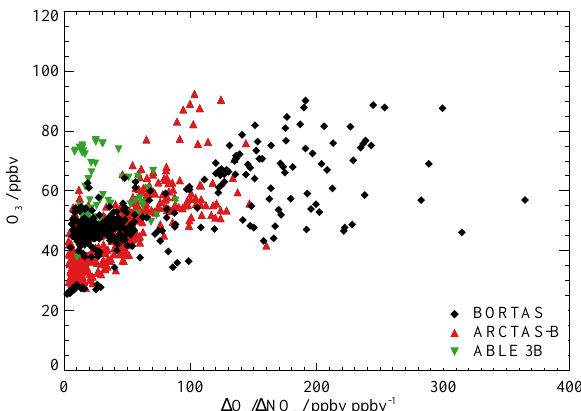
Fig. 14. Relationship between O 3 mixing ratio and OPE in boreal biomass burning plumes calculated from aircraft measurements made by the BORTAS (black diamonds), ARCTAS-B (red upward triangles), and ABLE 3B (green downward triangles) campaigns over eastern